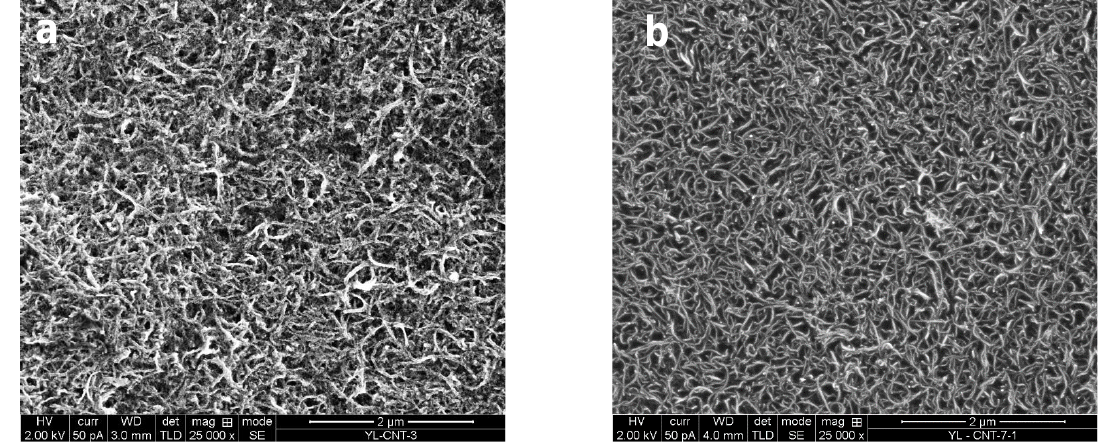
Figure 1. SEM images of coatings fabricated with an aqueous dispersion of Cheap Tubes CNTs ( a ), and a solvent-based dispersion of Nanocyl CNTs ( b ).